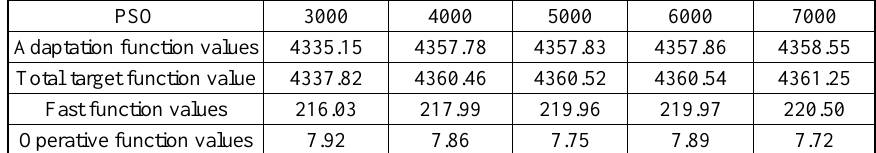
Table 3 . M 08 Particle swarm algorithm.